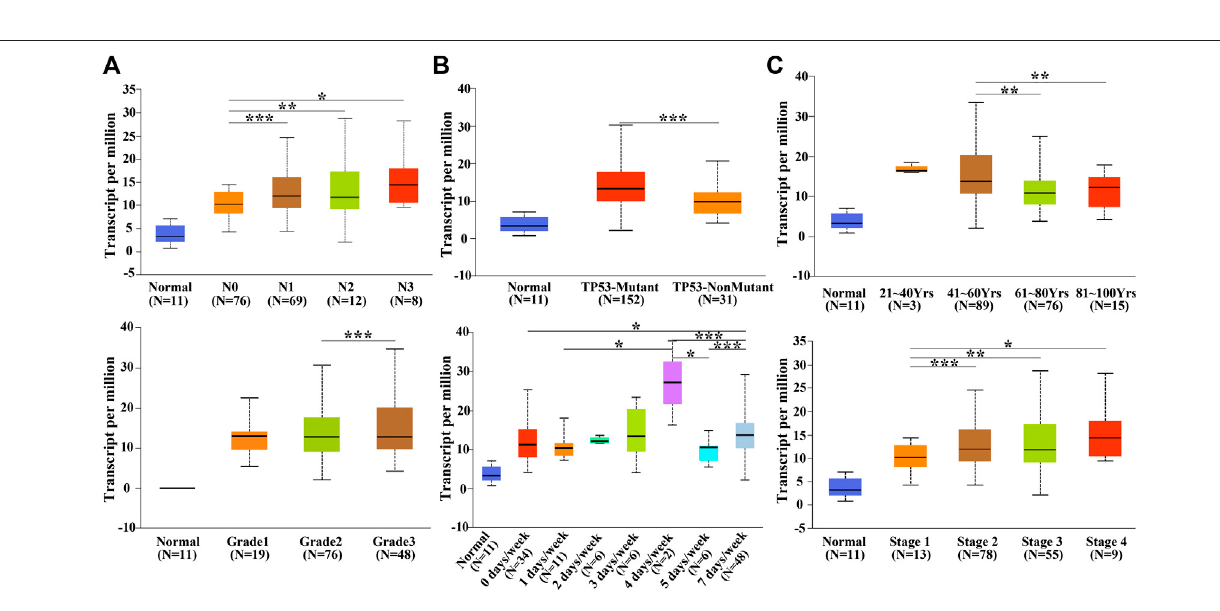
FIGURE3| SPDL1 expressionlevelwasrelatedtotheclinicopathologicalfeaturesofpatientswithESCAintheUALCANdatabase. (A) Lymphnodemetastasis; (B) TP53 mutation; (C) age; (D) grade; (E) drinking history; and (F) clinical stage. Normal esophageal tissues; ESCA, esophageal cancer; SPDL1, spindle apparatus coiled- coil protein